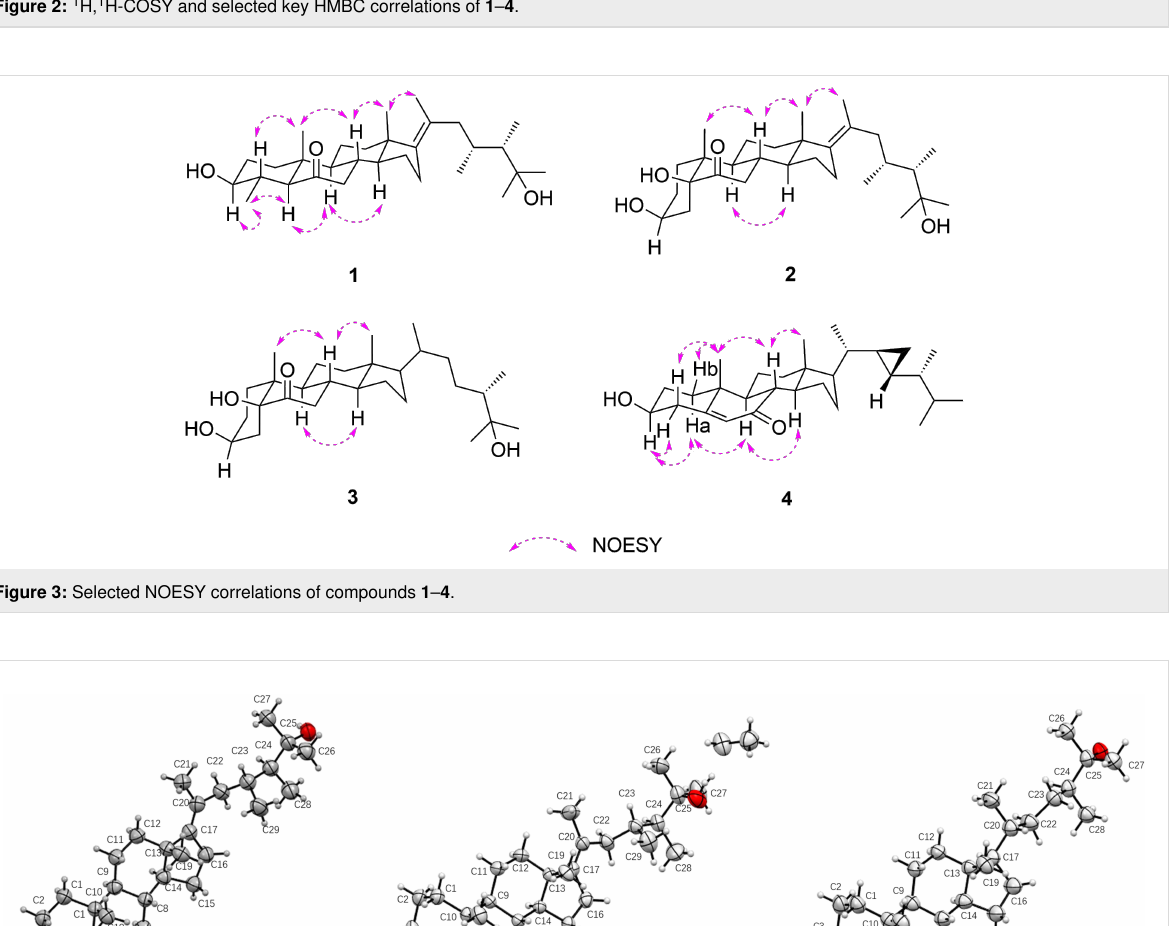
Figure 2: 1 H, 1 H-COSY and selected key HMBC correlations of 1 – 4 .